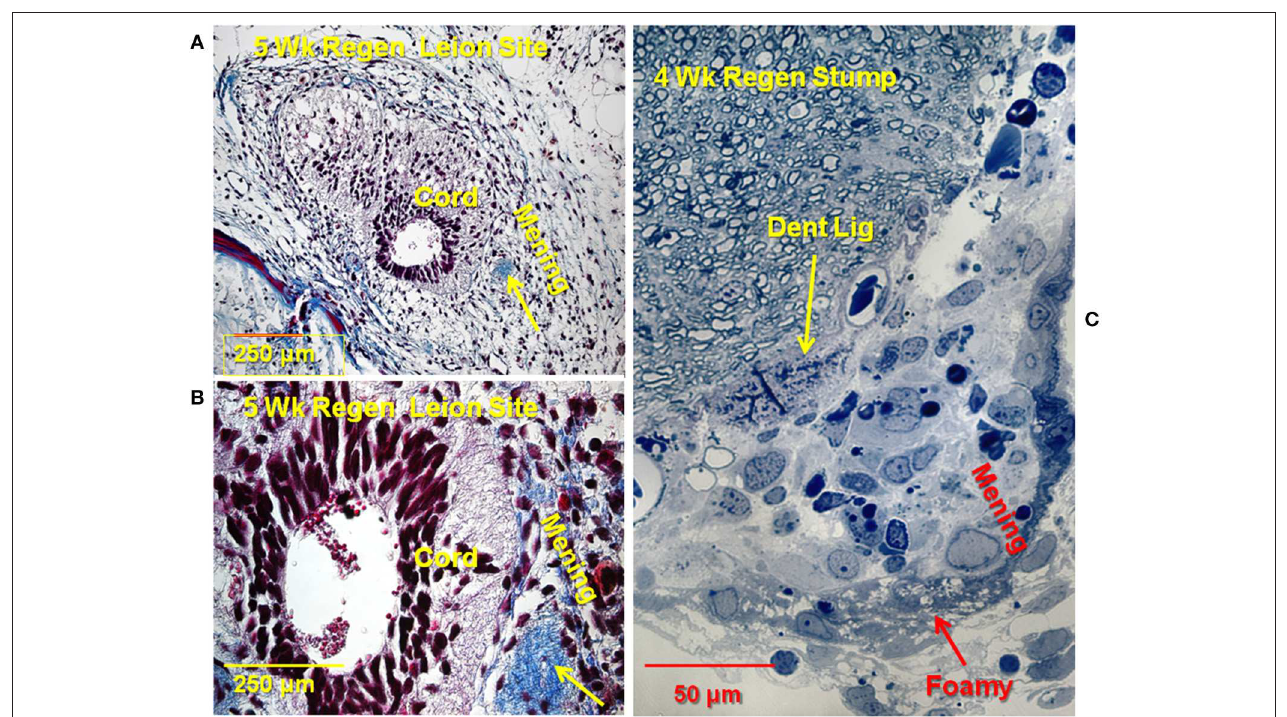
FIGURE 4 | Later stage of the lesion site: rejoined cord. (A) Trichrome stained section through 5 weeks regenerate lesion site. Cord is asymmetrical, with enlarged central canal, white matter not fully reconstructed. Extensive reactive meninges around the cord. Arrow: denticulate ligament. Collagen is blue. (B) Higher magnification view of a trichrome stained section through the 5 weeks regenerate. Extruded material visible in central canal Arrow: denticulate ligament. (C) Toluidine blue stained plastic thick section 4 weeks regenerate. Stump near lesion site. Reactive meninges with white blood cells and some foamy cells (red arrow), area of denticulate ligament (yellow arrow). Magnification bar shown in the lower portion of each image. Dent Lig, denticulate ligament; Mening, meninges; Wk,